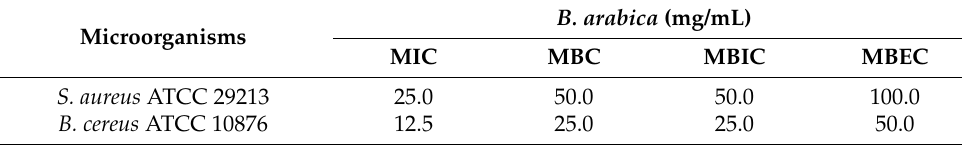
Table 4. MIC, MBC, MBIC, and MBEC results of B. arabica